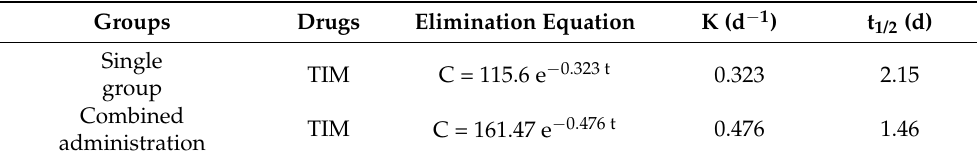
Table 11. Elimination parameters of TIM in